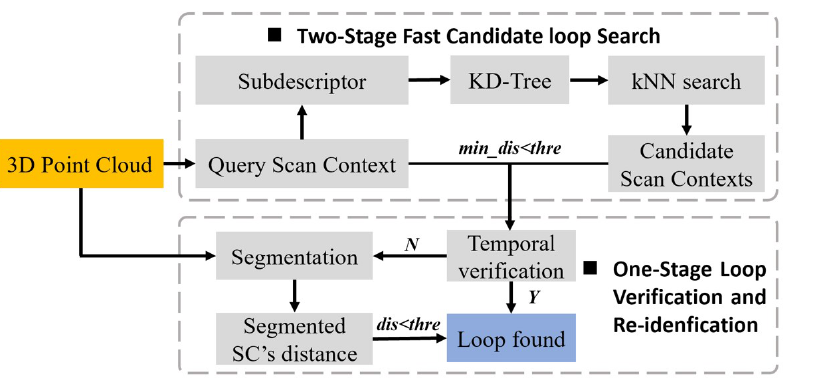
Figure 2. The pipeline of the proposed STV-SC framework. Grey dotted box above: the two-stage fast candidate loop closure search process, including a k-Nearest Neighbor (kNN) search process and a similarity scoring process. Grey dotted box below: our STV